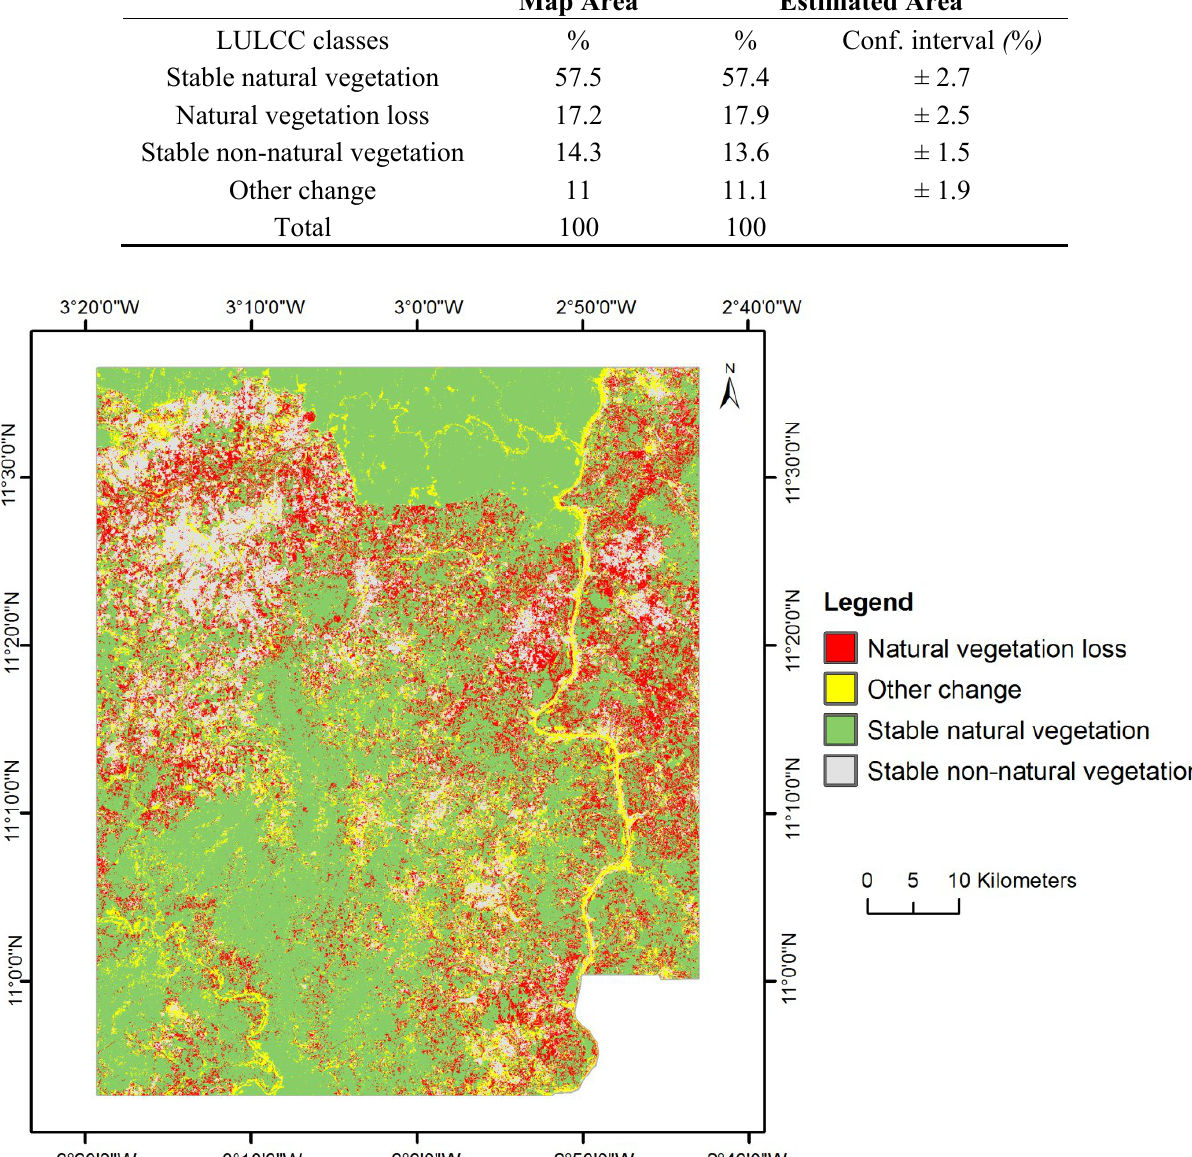
Figure 5. Distribution of LULCC in the study area between 1999 and